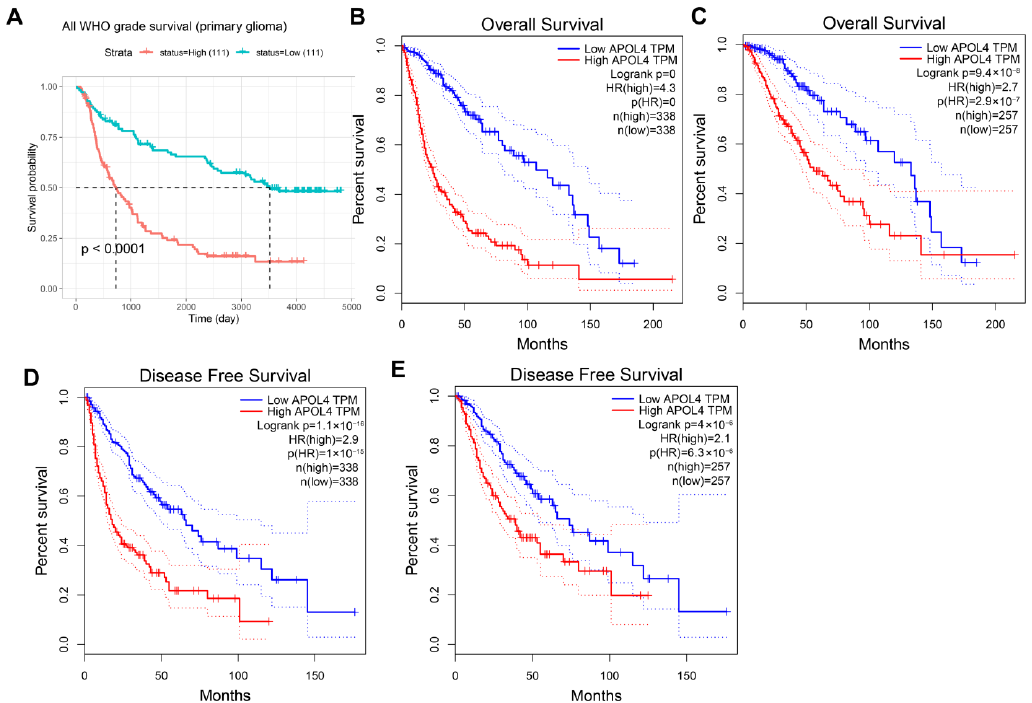
Figure 3. The APOL4 survival curves of gliomas. Compared to low expression, high APOL4 expression conferred a worse OS in glioma patients from the CGGA ( A ) and TCGA ( B ) databases. In the TCGA database, the association of APOL4 with OS ( C ) and DFS ( E ) in LGG. ( D ) The association of APOL4 with DFS in GBM.